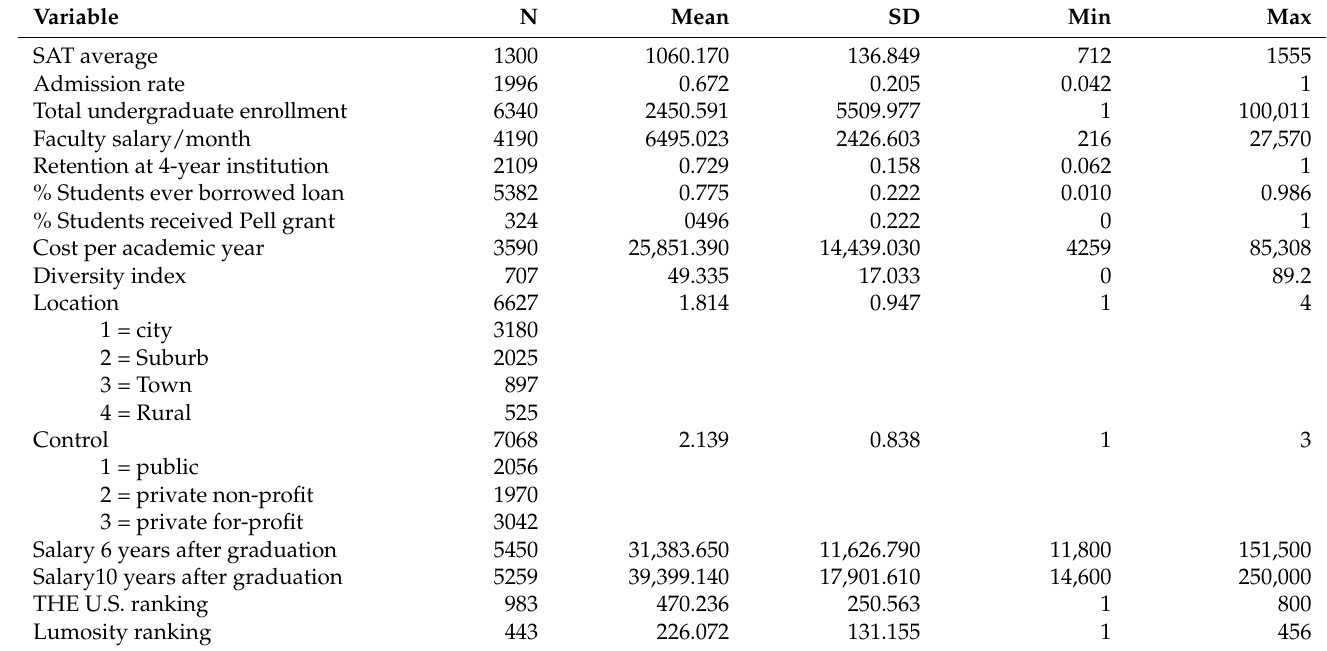
Table A1. Summary statistics from college scorecard data 2017–2018.